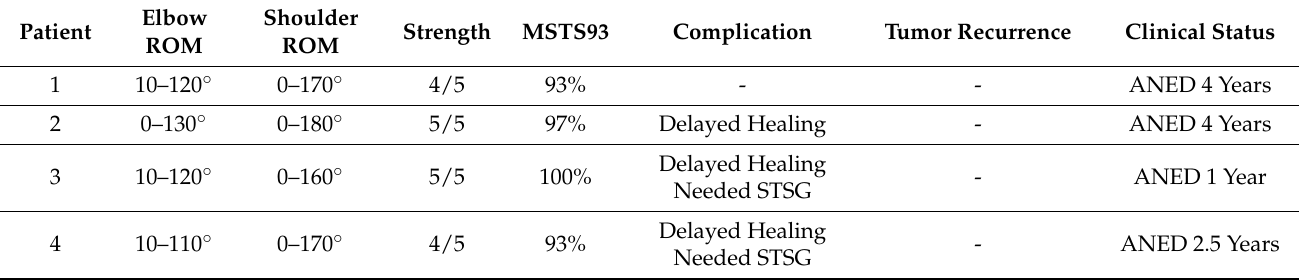
Table 2. Outcomes Following